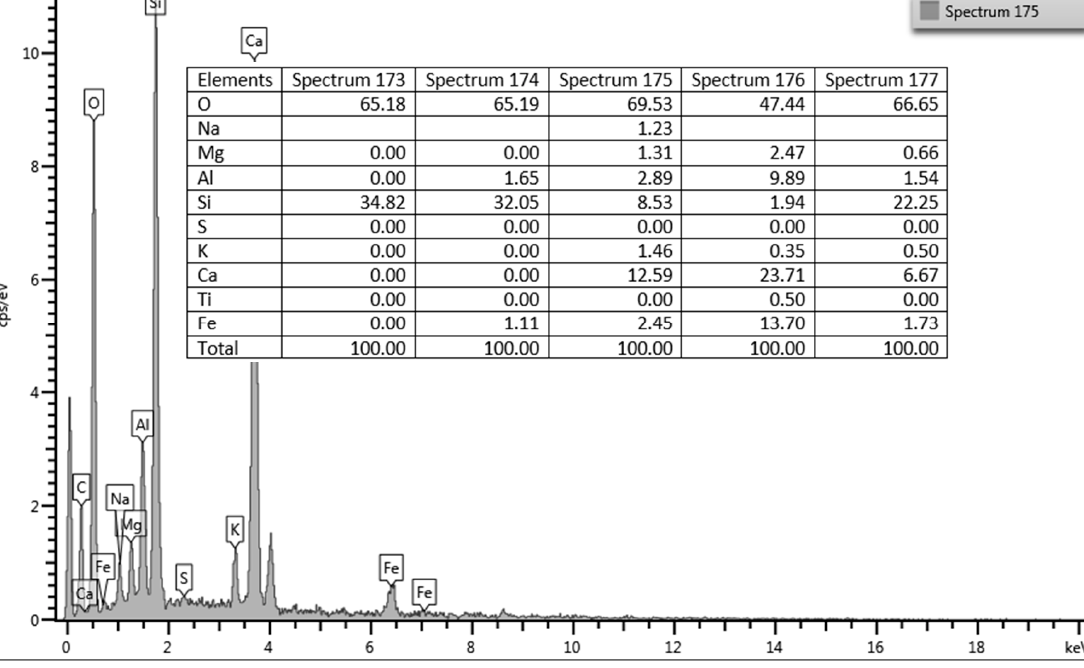
Figure A2. EDS analysis from the spectrum 175 of OPC mortar (the insert table is the % elemental composition of other spectrums).